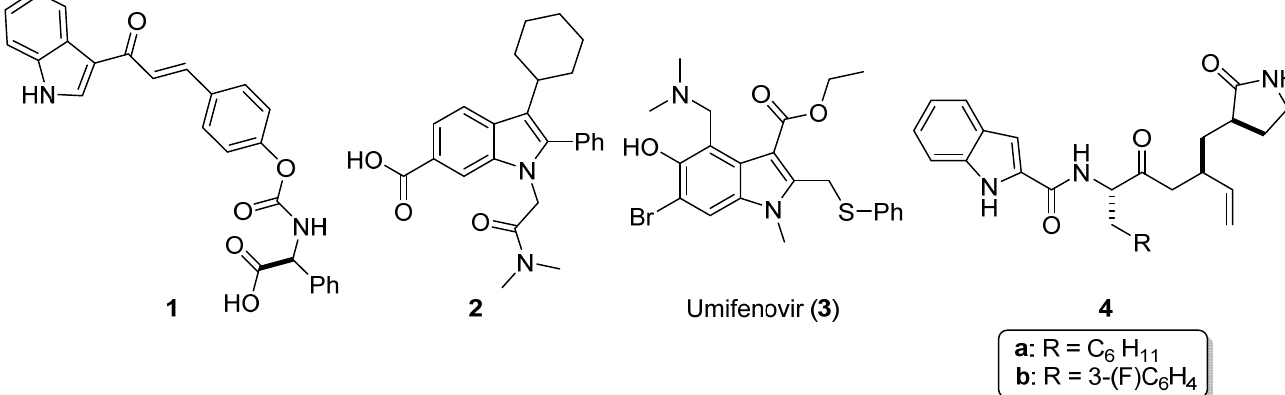
Figure 1. Indole derivatives with biological activity: indole derivative 1 is a potent HCV NS3/4A serine protease inhibitor; indole- N -acetamide inhibitor 2 is a potent inhibitor of the HCV NS5B Polymerase; umifenovir ( 3 ) has been demonstrated to inhibit in vitro infection with globally prevalent pathogenic viruses, including hepatitis C; indole derivatives 4 are the strongest known SARS-CoV-2-M pro inhibitors with inhibition constants in the two-digit nanomolar range.